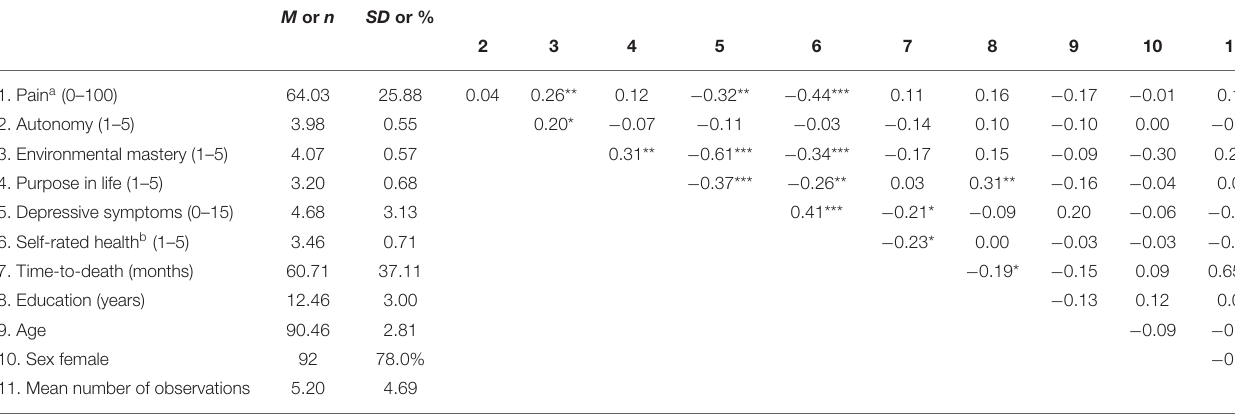
TABLE 1 | Means, standard deviations, and intercorrelations of study variables at baseline (T1, 2009). M or n SD or % 2 3